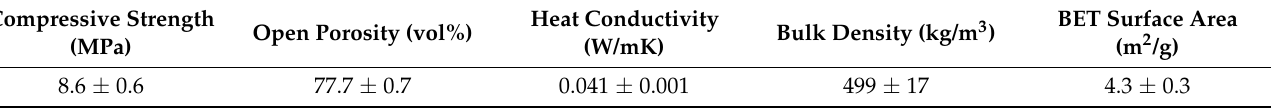
Table 7. Physical properties of developed GP foams for multifunctional